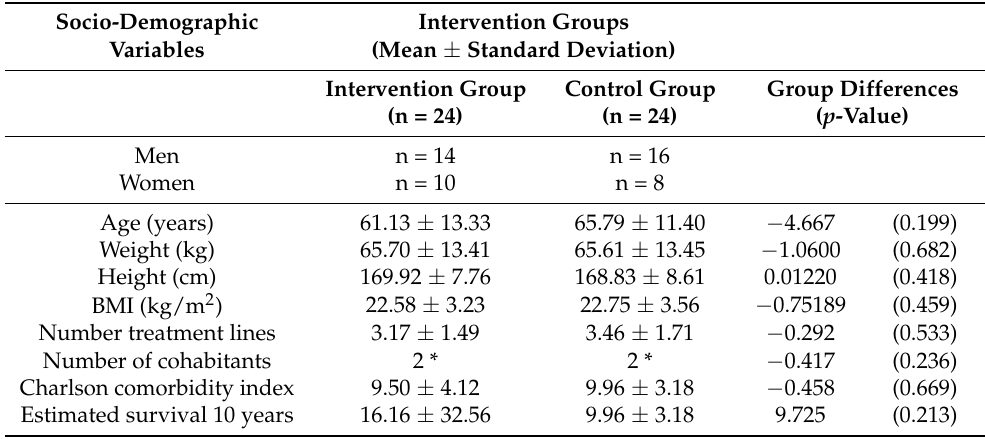
Table 1. Sociodemographic variables of the sample at baseline evaluation. Socio-Demographic Intervention Variables